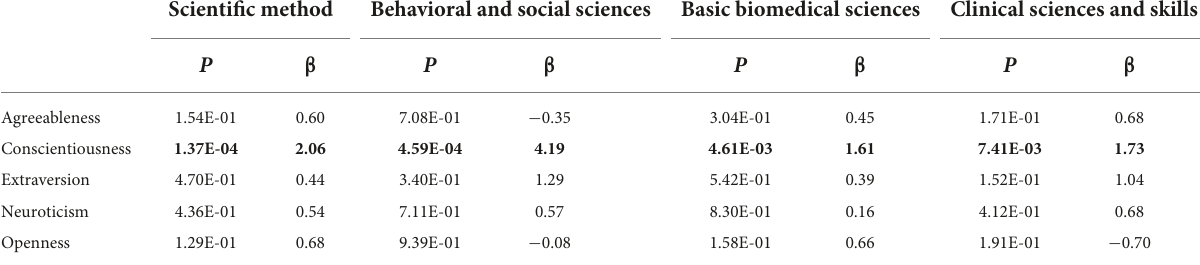
TABLE 2 The association analysis between the neuroticism extraversion openness personality inventory and academic achievements.